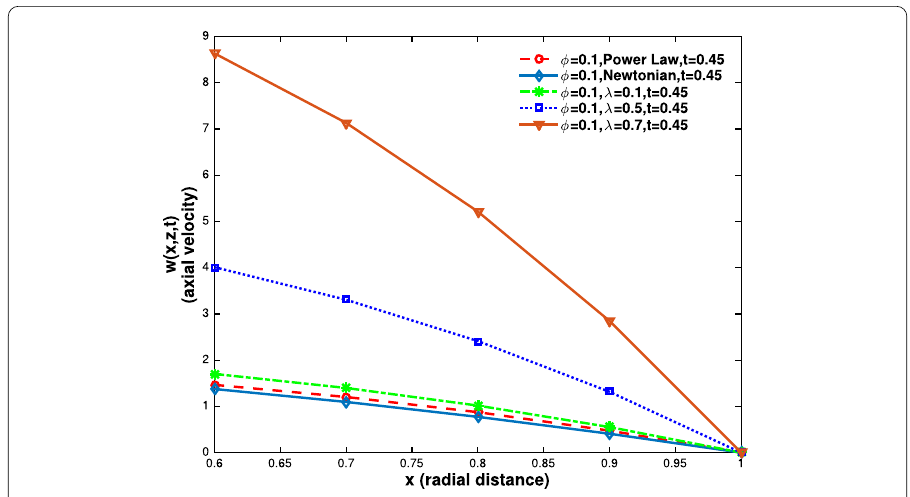
Figure 16 Axial velocity vs radial distances (near wall) for φ = 0.1, λ = 0.1,0.5,0.7 at z = 28, t = 0.45, τ y = 0.4, K = 1.6, power law model ( λ → 0) and Newtonian fluid ( λ → 0, ¯ K = 0.035, n = 1)